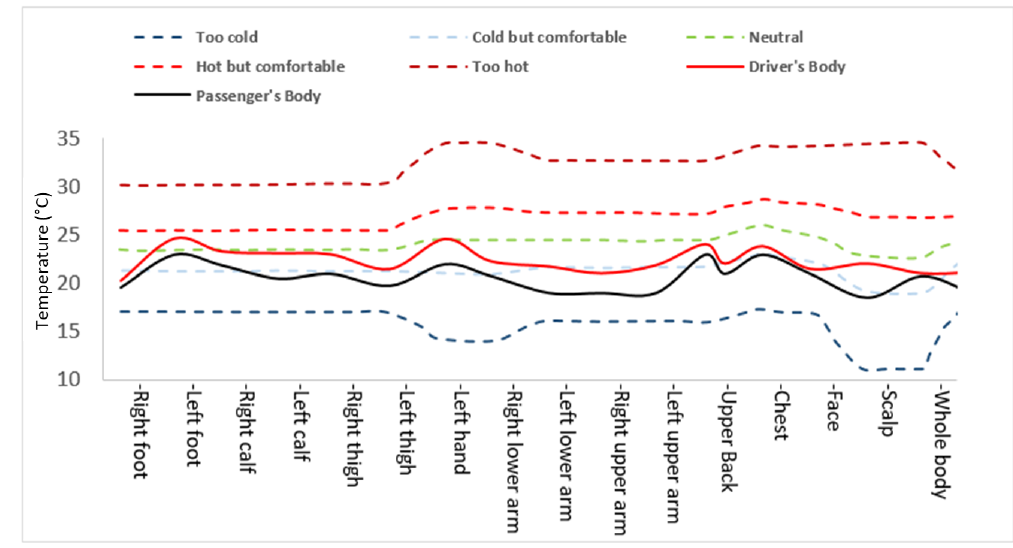
Figure 8. Local temperature after 1200s.